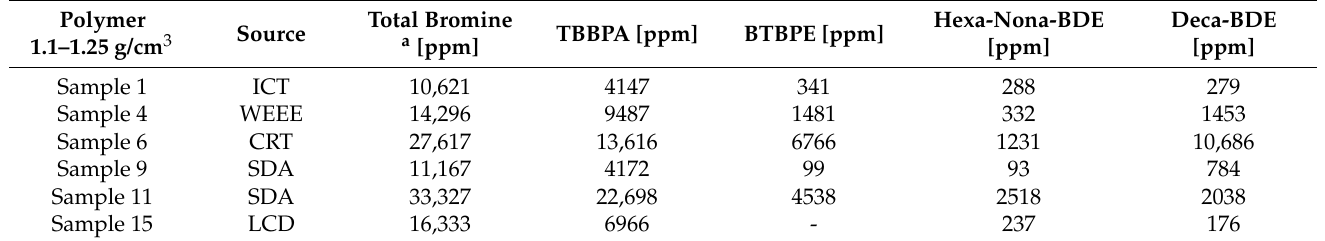
Table 5. Overview of GC-ECD results of selected samples from density fraction 1.1–1.25 g/cm 3